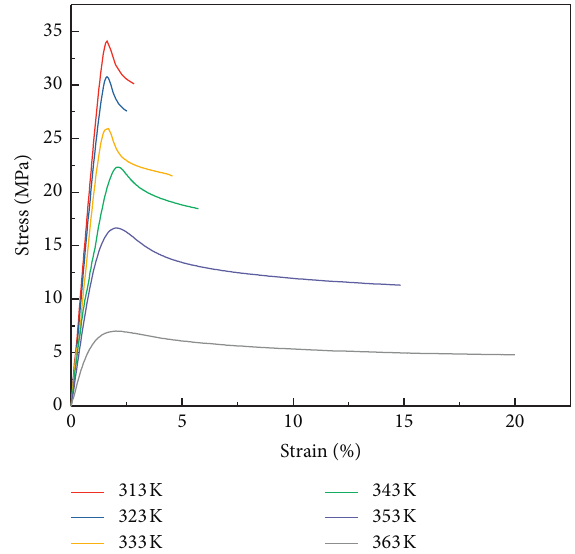
Figure 1: Tensile data of ABS at different temperature (below glass transition